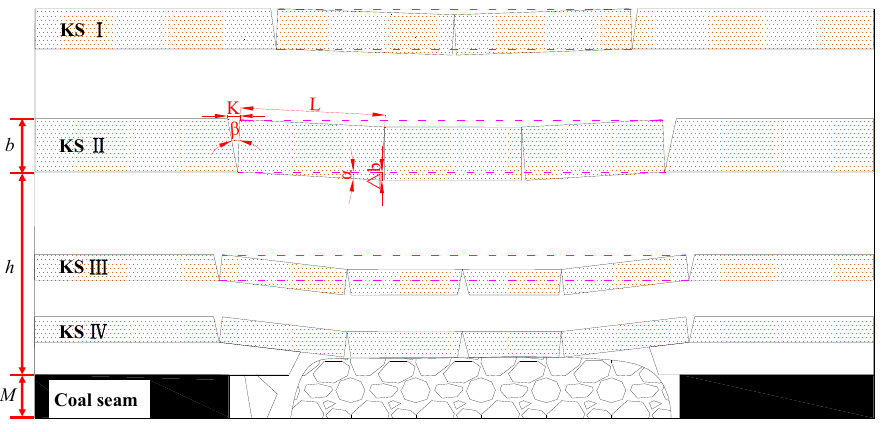
Figure 11. Model on KS fracturing and fracturing apertures.